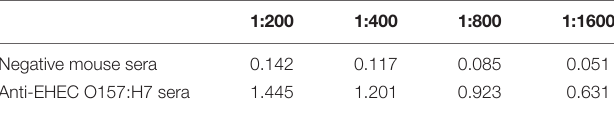
TABLE 3 | Z3276 expression in vivo using indirect ELISA.